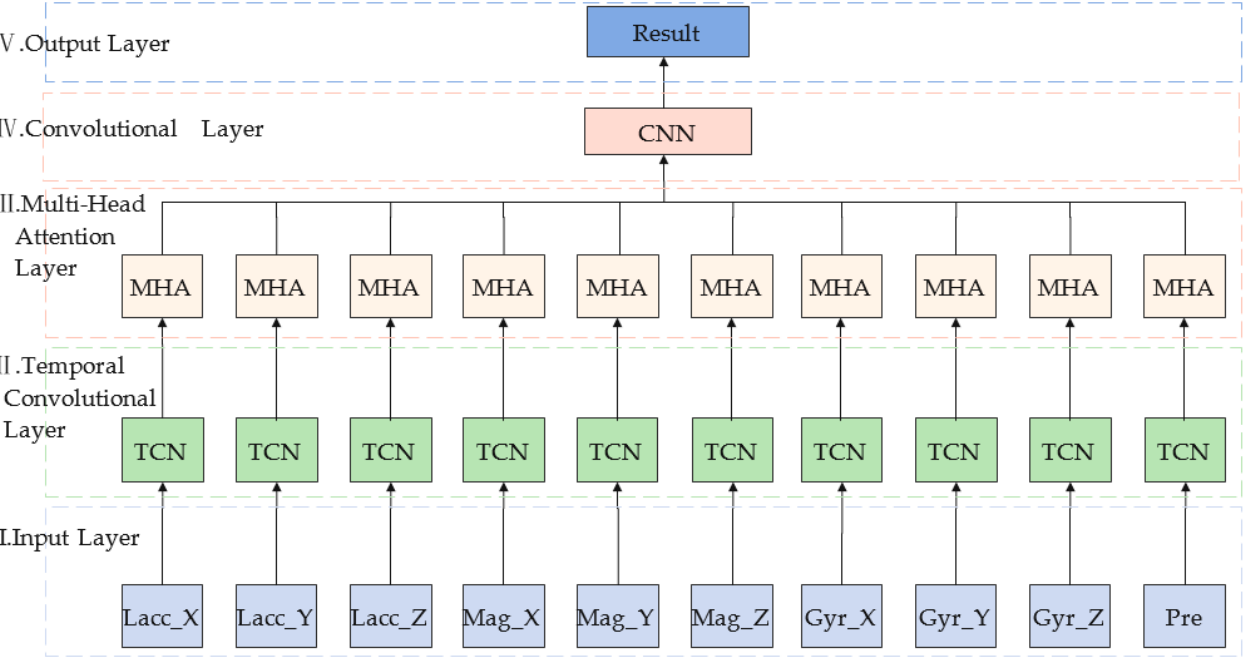
Figure 1. Schematic diagram of the TCMH model framework.